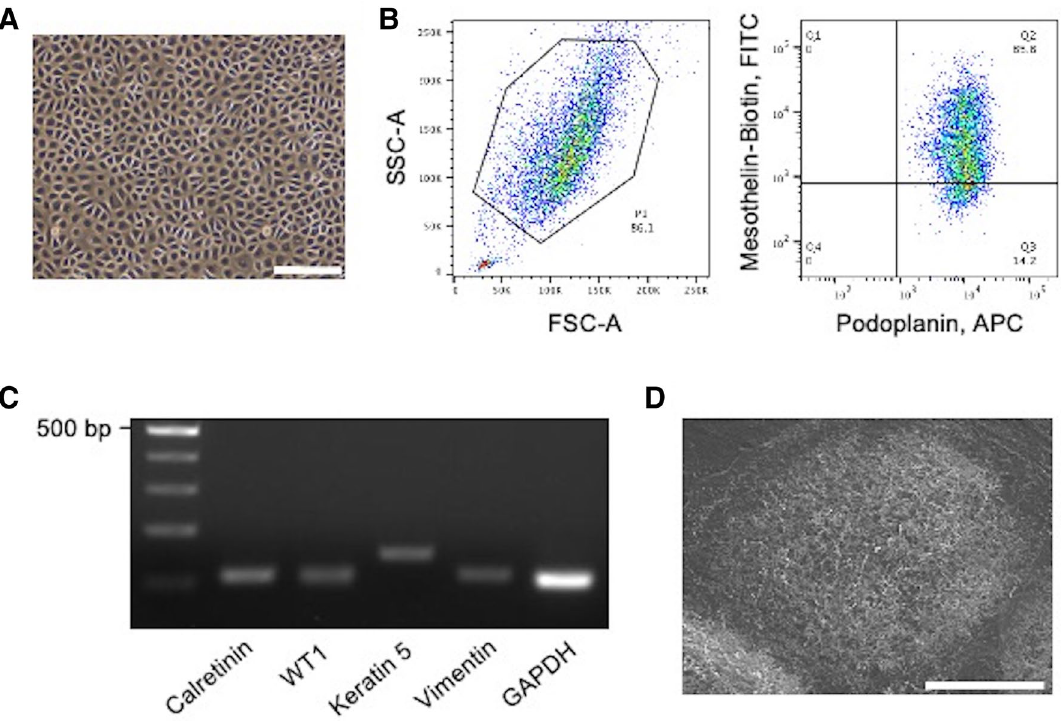
Figure 2. Isolation and characterization of human PMCs from pleural lavage. ( A ) Representative photomicrograph of confluently growing cells obtained from pleural lavage in PSP patient. ( B ) Representative fluorescence-activated cell sorting dot plots of cultured cells. The left panel shows plots of the forward- scattered (horizontal) versus side-scattered (vertical) axes. The right panel represents the fluorescent intensities of APC (conjugated with the anti-podoplanin antibody) and FITC (conjugated with the biotinylated anti- mesothelin antibody), respectively. The Q2 area indicates the gateway for sorting PMCs (podoplanin-positive and mesothelin-positive cells). ( C ) The expression of MC markers (calretinin, WT1 , keratin 5, and vimentin) examined in PSP-PMCs by RT-PCR. GAPDH was amplified as a control gene for RT-PCR. Gel electrophoresis of amplified products showed a discrete band with expected fragment size from each reaction. ( D ) SEM image of PSP-PMCs showing numerous microvilli characteristic of MCs. Scale bars represent 200 μm ( A ) and 20 μm ( D ), respectively. APC allophycocyanin, bp base pair, FITC fluorescein isothiocyanate, FSC-A forward scatter area, GAPDH glyceraldehyde 3-phosphate dehydrogenase, SSC-A side scatter area, WT1 Wilms’ tumor